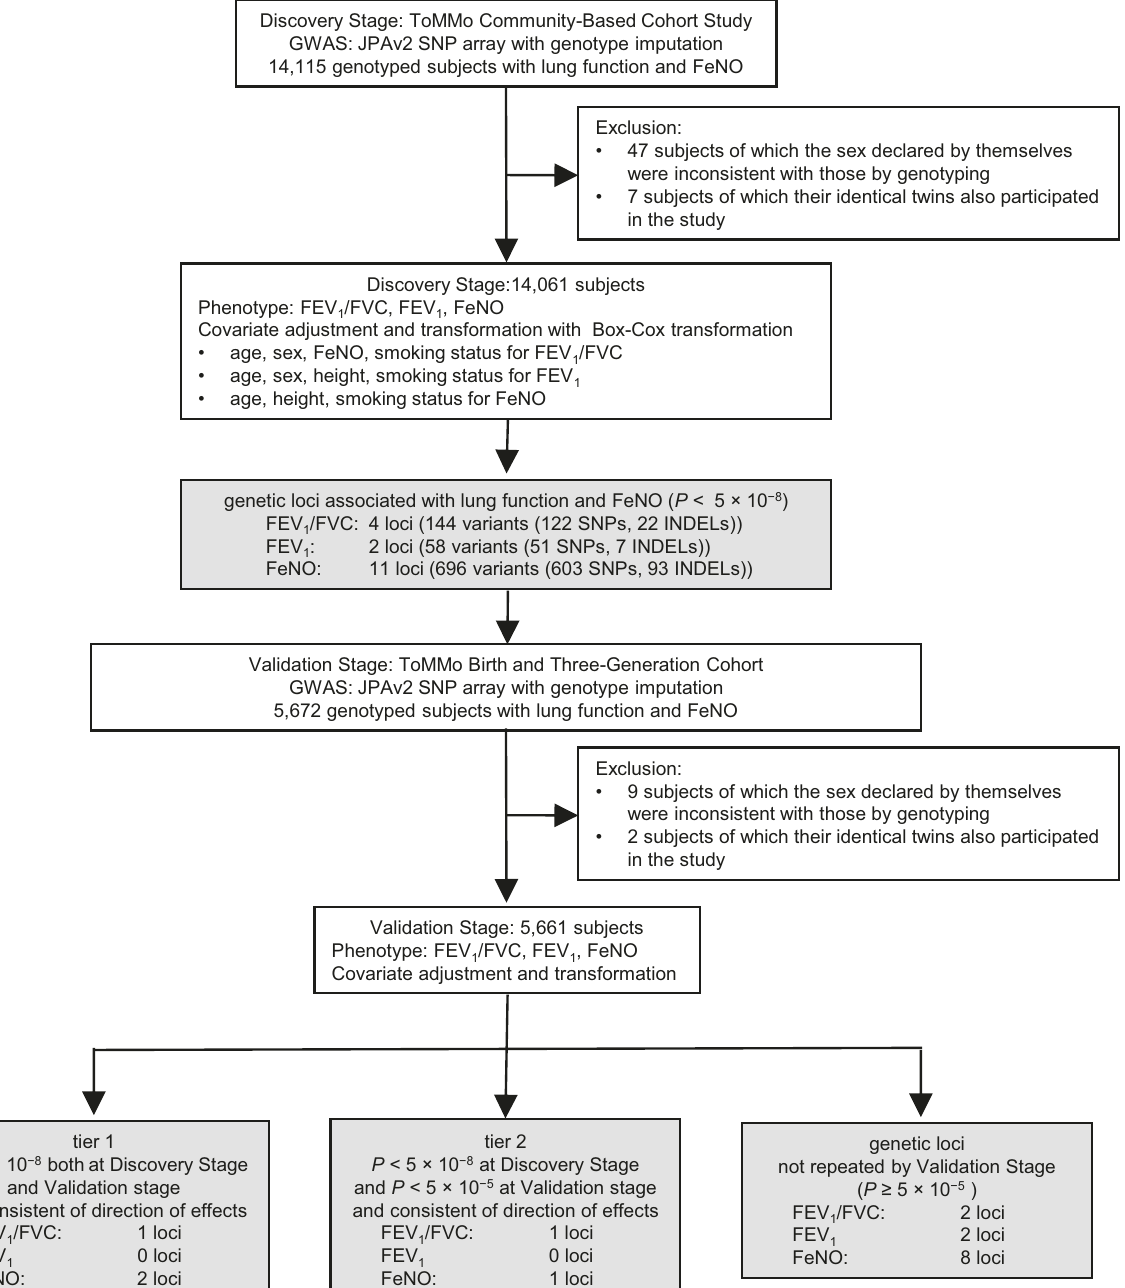
Fig. 1 Study design for investigating genetic factors that determine lung function and FeNO. The study design for investigating the genetic factors that determine lung function and FeNO is shown. Note that tier 1 loci have P < 5 × 10 − 8 both at the Discovery Stage and Validation Stage, while tier 2 signals have P < 5 × 10 − 8 at the Discovery Stage and P < 5 × 10 − 5 at the Validation Stage with consistent directions of effect. FeNO exhaled nitric oxide, FEV 1 forced expiratory volume in one second, FVC forced vital capacity, SNP single nucleotide polymorphism, INDEL insertion or deletion, JPAv2 Japonica array version two loci for FEV 1 were 4q31.21 in GYPA~HHIP-AS1 and 5p12 in FGF10 (Fig. 2d, Table 1, Supplementary Data 2).